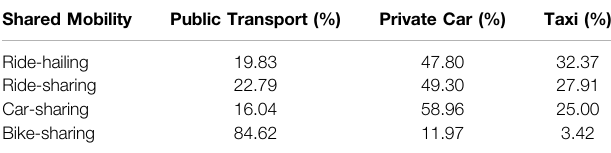
TABLE 4 | Travel modal shift from shared mobility to conventional